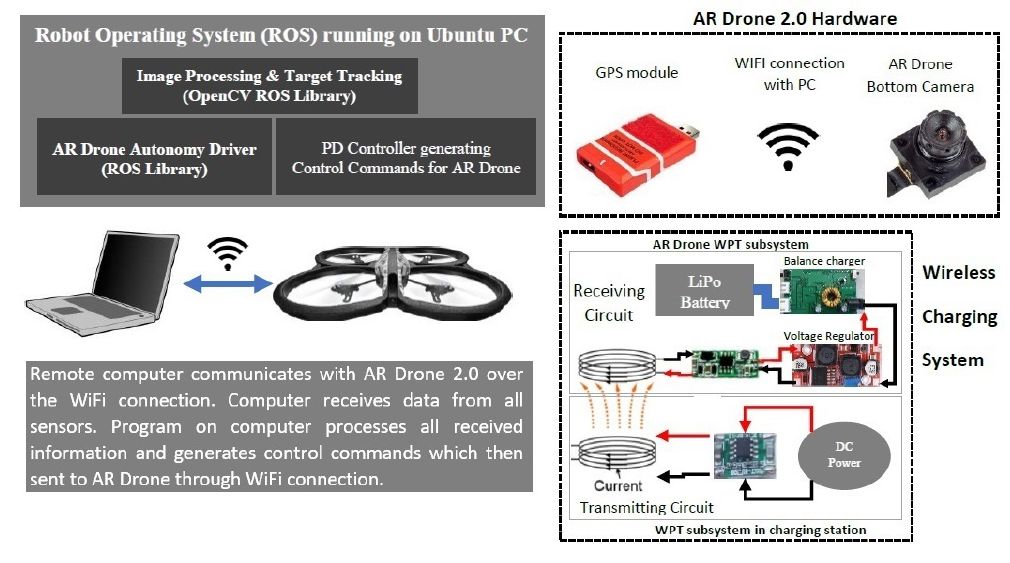
Figure 4. System diagram.